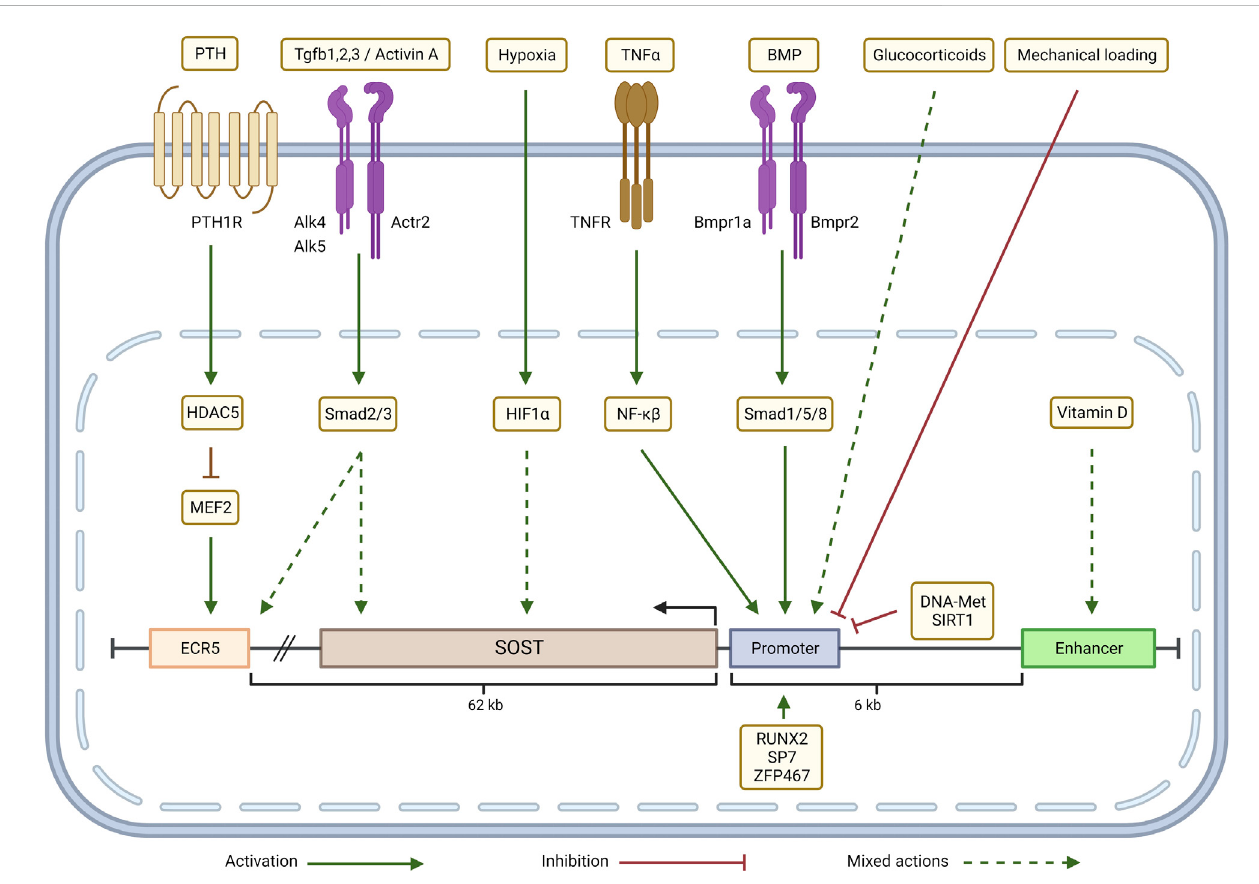
FIGURE 3 Transcriptional regulation of SOST in the CKD-MBD context: Parathyroid hormone (PTH) inhibits SOST expression through a HDAC5 effect on MEF2 which regulates ECR5. Depending on the cellular context, TGF β /Activin signaling (via Smad2/3) either up-regulates SOST expression by acting through ECR5 ordown-regulates SOST. Hypoxia (via HIF-1 α ), glucocorticoids and VitaminD up-ordown-regulateSOST expression inacontext-dependentmanner. TNF α , throughaNF- κβ dependentmechanism,andBMPsignaling,viaSmad1/5/8,increaseSOSTtranscriptionbytargetingthepromoter.SOSTtranscriptionis negatively regulated by mechanical loading, promoter methylation (DNA-Met) and by epigenetic modi fi cations induced by SIRT1. Zfp467 and transcription factors RUNX2 andSP7bind totheSOSTpromoterandactivate SOST expression.AdaptedfromSebastianand Loots(Bone96:76-84, 2018). Graphiccreated with